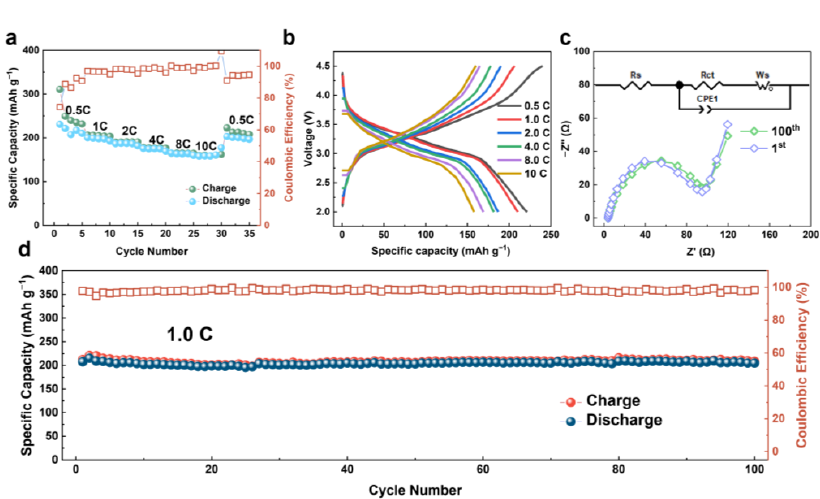
Figure 4. Electrochemical performance of FeF 3 @C-LIBs: ( a ) Discharge/charge capacities at different rates; ( b ) Discharge/charge profiles at corresponding rates; ( c ) Comparison of impedance spectra for 1 and 100 cycles of FeF 3 @C LIBs at open-circuit voltage; ( d ) Long-term cycle stability of the FeF 3 @C cathode at 1.0 C.